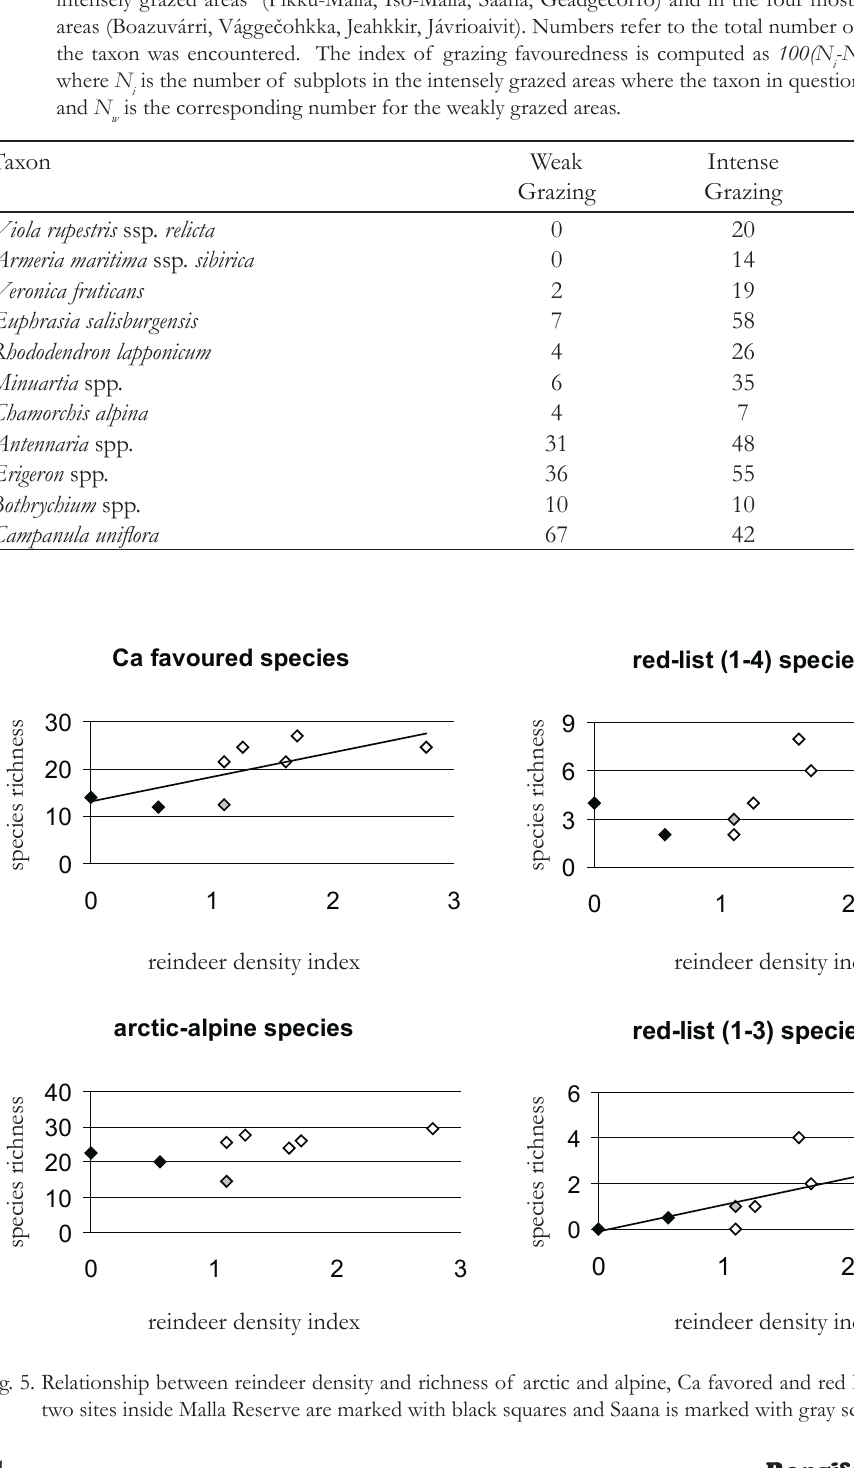
-N )/max(N , N ) , i w i w